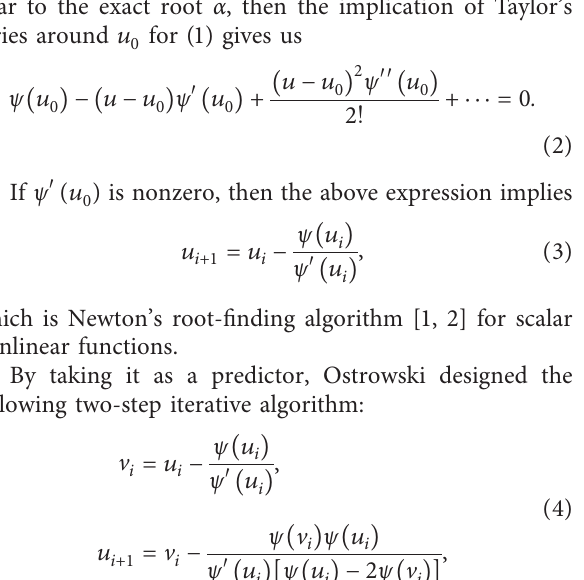
Algorithm 1. For a given u , compute the approximate 0 solution u i + by the following iterative schemes 1